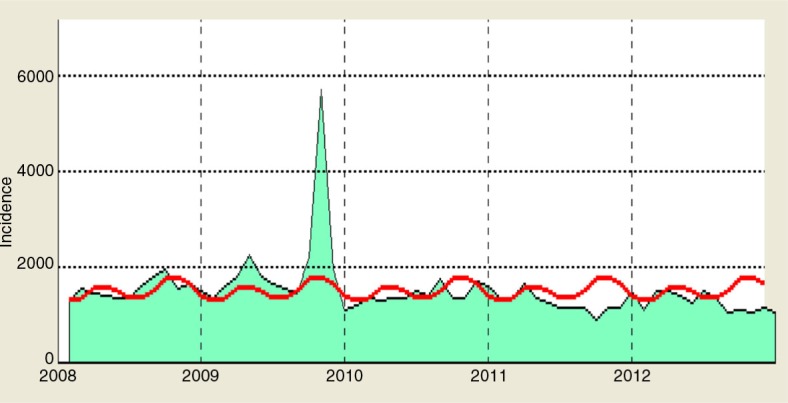
Cycle and seasonality of seasonal ILI from 2008 to 2012. The red line is the average number of ILI cases estimated from 2008 to 2012 . The green area expresses the number of ILI cases over the years 2008–2012 in the Ha Nam province .